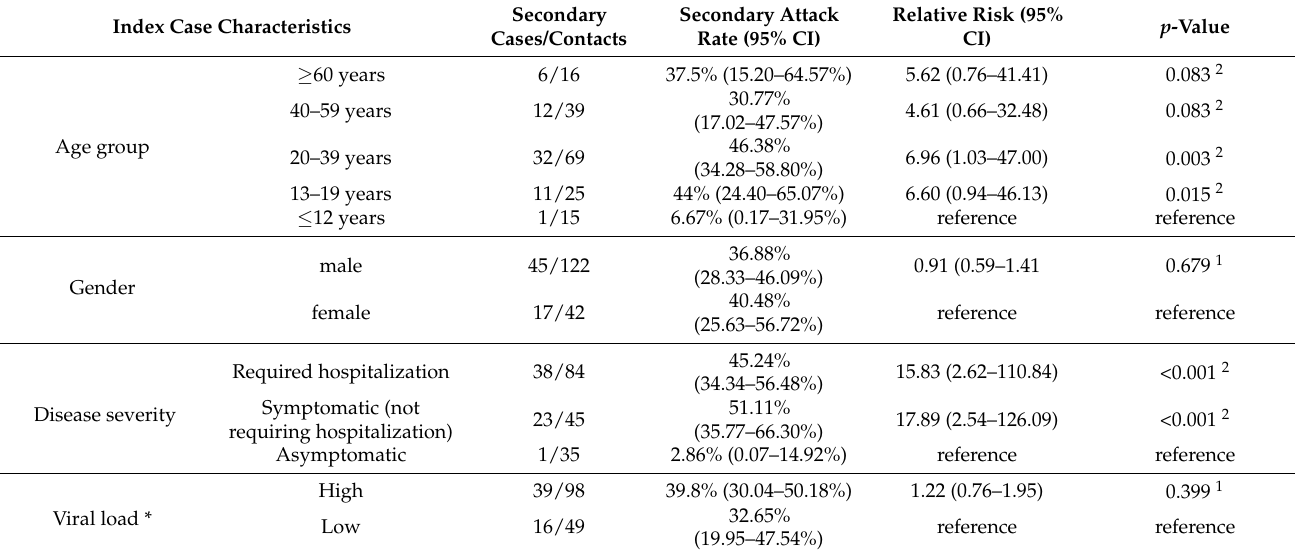
Table 3. Risk for secondary transmission according to index case